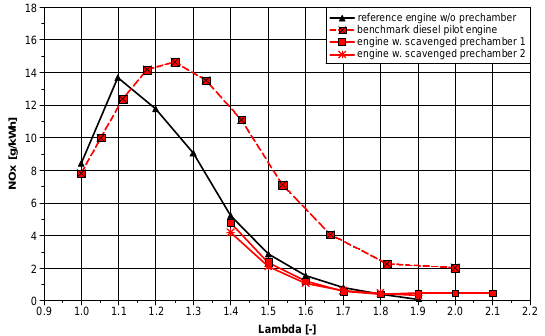
Fig. 18. Raw NO x emissions for the operating point 1 (1400 rpm/50 Nm)